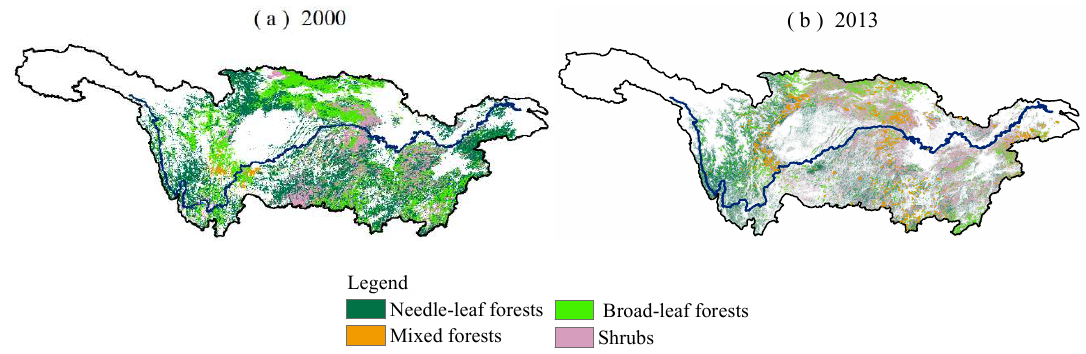
Figure 10. Forest vegetation types in 2000 ( a ) and 2013 ( b ). Table 4. The land-use in the Yangtze River basin (Area, unit: km 2 ; Percent, unit: %).